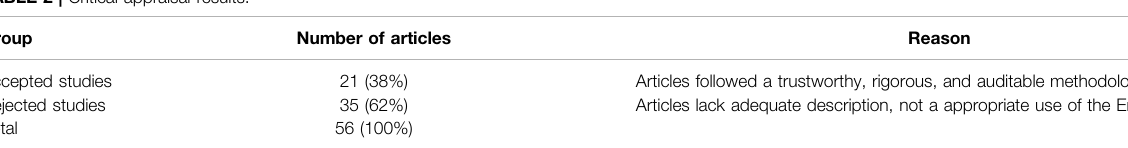
TABLE 2 | Critical appraisal